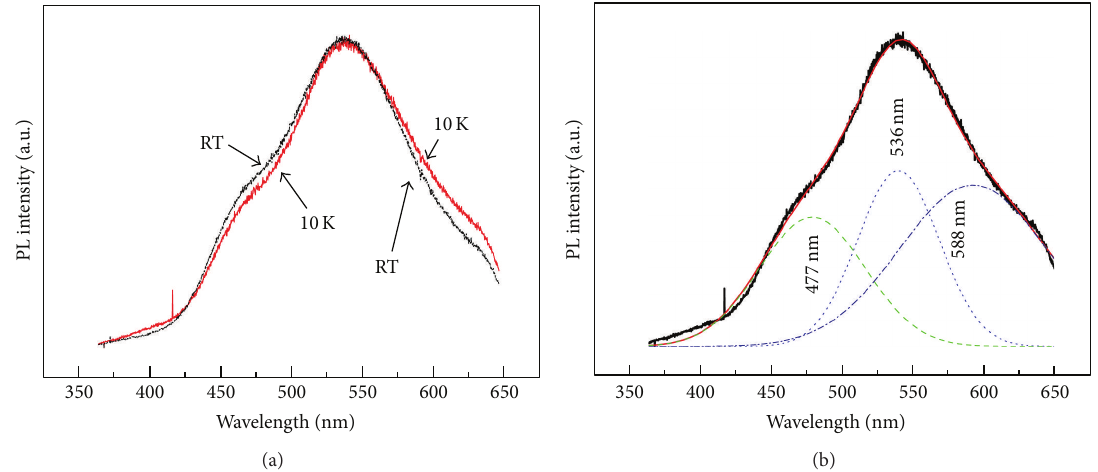
Figure 4: The photoluminescence spectra of the as-prepared 1D nanostructures excited with a He-Cd laser (442 nm) at 10k and room temperature (RT) (a), and the Gaussian fitting of the photoluminescence spectrum obtained at 10k